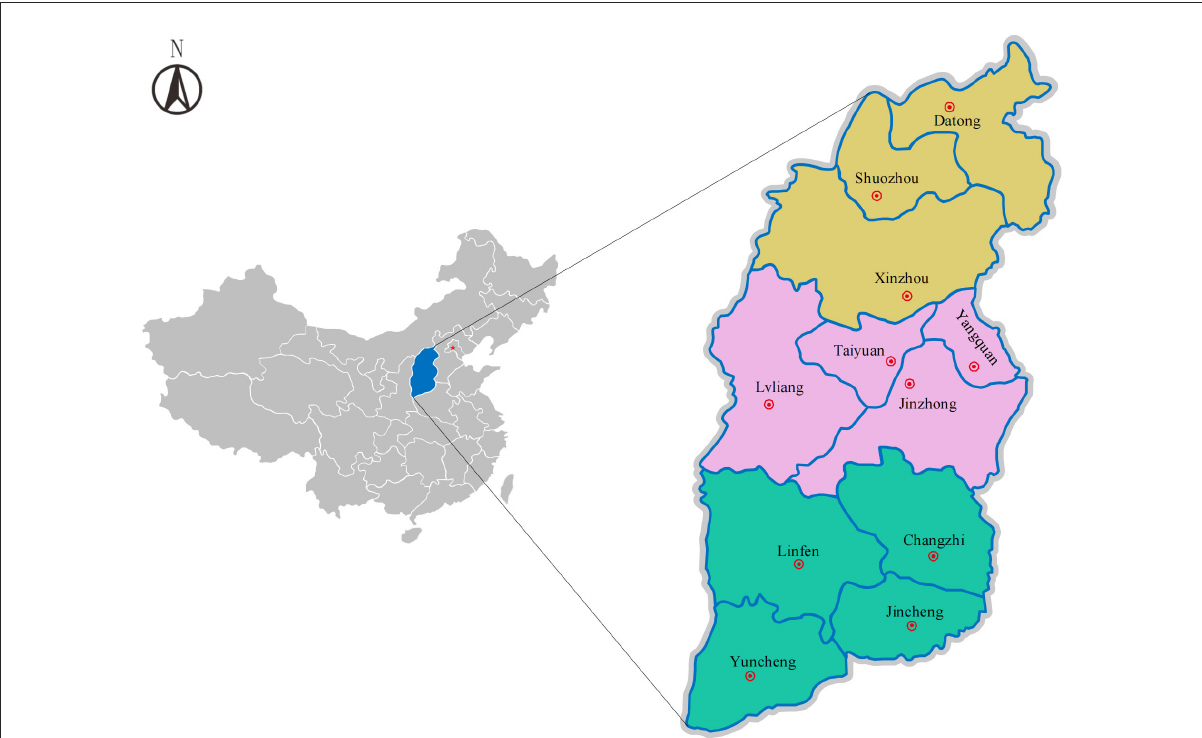
FIGURE1 Map showing the geographical locations in Shanxi Province, north China. Yellow, pink and green colors represent the geographical location of Northern Shanxi (Datong, Shuozhou, Xinzhou), Central Shanxi (Taiyuan, Lvliang, Jinzhong, Yangquan) and Southern Shanxi (Changzhi, Jincheng, Linfen, Yuncheng), respectively. Red star mark: Beijing, the capital of China. Double circles: Eleven cities in Northern, Central and Southern Shanxi.